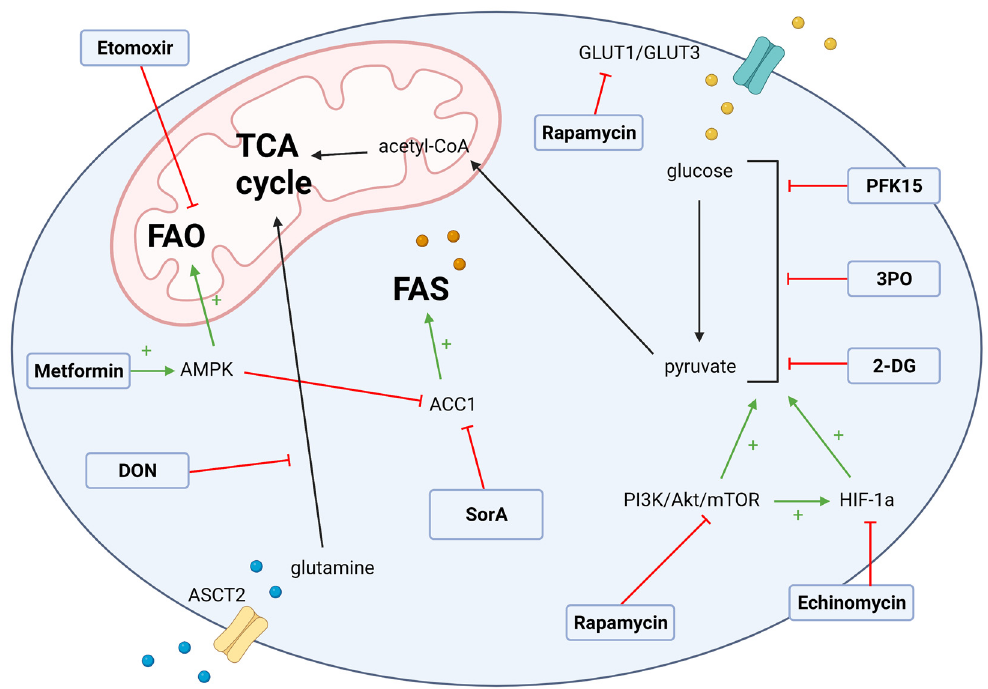
Figure 1. Potential T cell metabolism therapeutic targets in GvHD. Alloreactive T cells undergo a shift in metabolism characterized by an upregulation of glycolysis, along with increased reliance on glutamine and fatty acid metabolism. Regulators of these metabolic pathways serve as promising drug targets for the treatment of GvHD. The upregulation of glycolysis is mediated by the transcription factor HIF-1 α and the nutrient sensor mTOR, which may be targeted by echinomycin and rapamycin, respectively. The drugs PFK15, 3PO, and 2-DG also interfere with glycolysis. PFK15 and 3PO are both inhibitors of PFKFB3, and 2-DG inhibits the glycolytic enzymes hexokinase and glucose-6-phosphate isomerase. Fatty acid metabolism is regulated by the acetyl CoA carboxylases and the nutrient sensor AMPK. Soraphen A is an ACC1inhibitor, which promotes FAO while suppressing fatty acid synthesis. Metformin is an AMPK agonist, which similarly upregulates fatty acid oxidation. Etomoxir is an inhibitor of fatty acid oxidation and may offer therapeutic benefits in GvHD. Glutamine metabolism may be another promising pathway for therapeutic targeting in GvHD. DON, an inhibitor of glutamine-utilizing enzymes, has been shown to suppress Th17 proliferation in mice, but its therapeutic benefits have yet to be tested in the context of GvHD. ACC1, acetyl coenzyme A carboxylase 1; acetyl-CoA, acetyl coenzyme A; Akt, Protein Kinase B; AMPK, adenosine monophosphate-activated protein kinase; ASCT2, alanine/serine/cysteine transporter 2; 2-DG, 2-deoxy-d-glucose; DON, 6-diazo-5-oxo- L -norleucine; FAO, fatty acid oxidation; FAS, fatty acid synthesis; Glut1/Glut3, glucose transporter 1/glucose transporter 3; HIF-1 α , hypoxia inducible factor 1-alpha; mTOR, mechanistic target of rapamycin; PFK15, 1-(4-pyridinyl)-3-(2-quinolinyl)-2-propen-1-one; PI3K, phosphoinositide 3-kinase; 3PO, 3-(3-pyridinyl)-1-(4-pyridinyl-2-propen-1-one); SorA, Soraphen A; TCA cycle, tricarboxylic acid